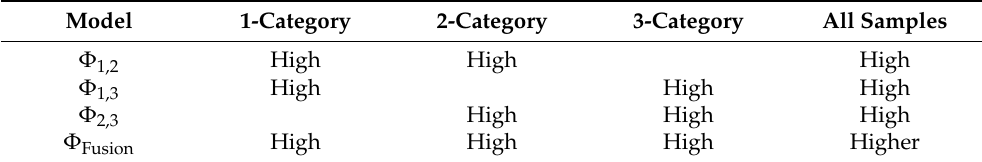
Table 10. Schematic diagram of voting effect for the three-model fusion’s joint model and its sub-models. Model 1-Category 2-Category 3-Category All Samples Φ 1,2 High High High Φ 1,3 High High High Φ 2,3 High High High Φ Fusion High High High